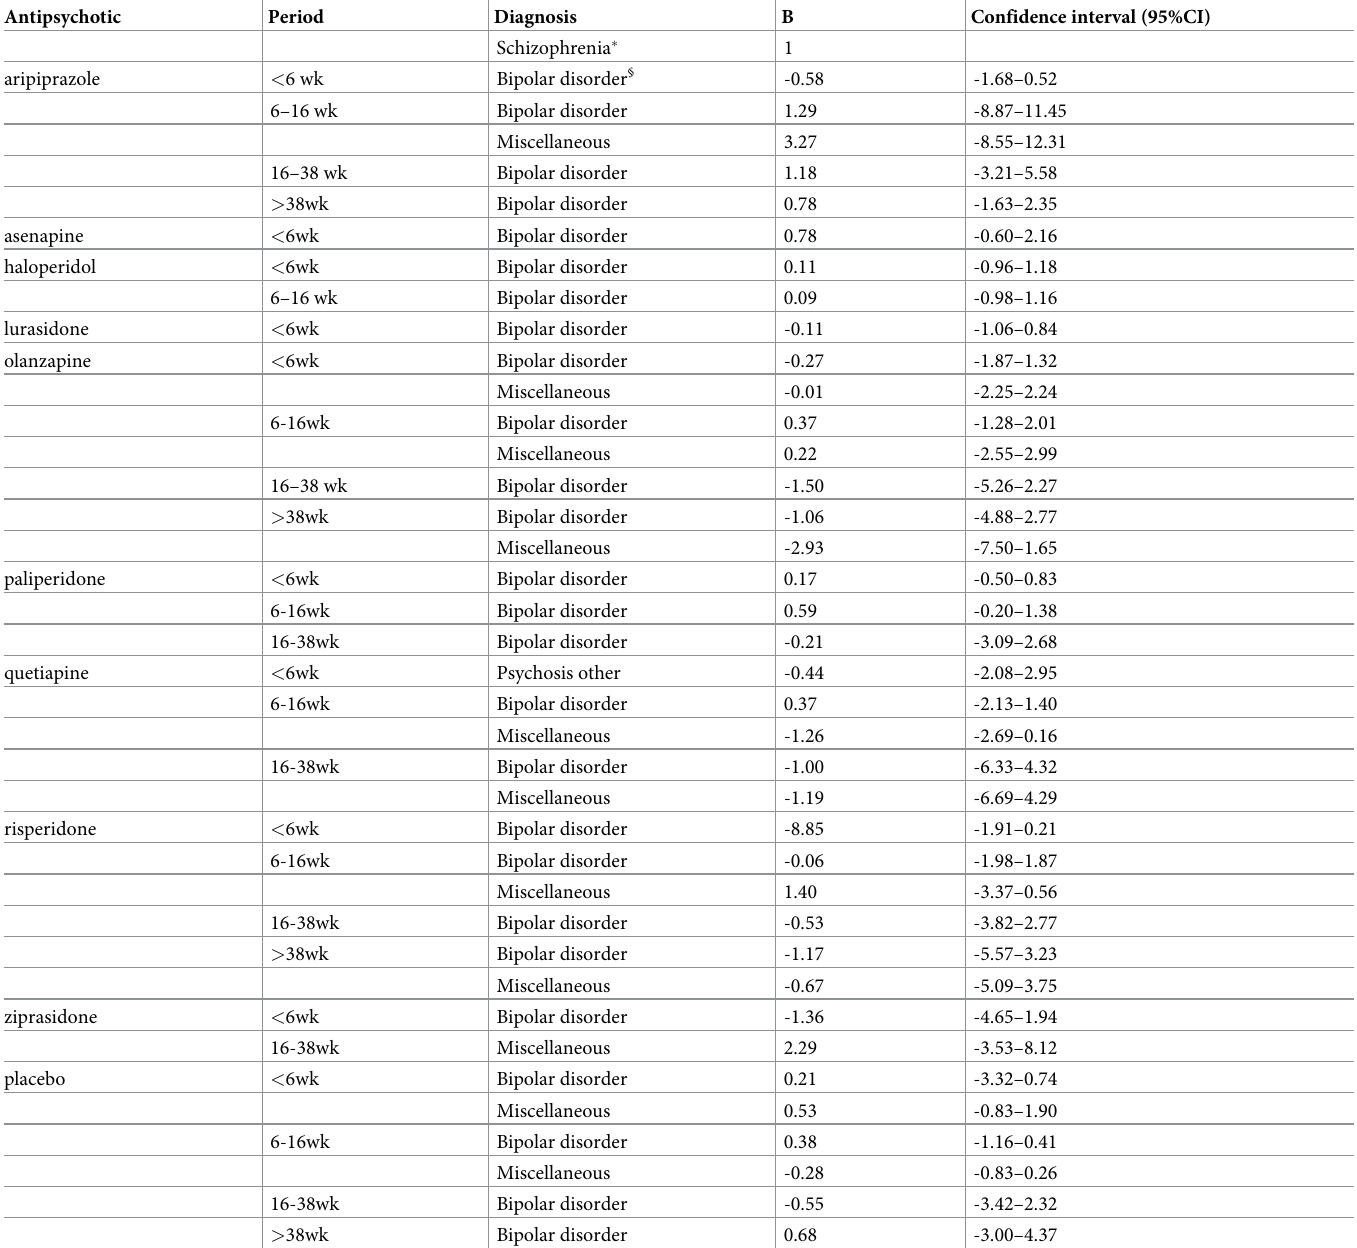
Table 4. Meta-regressions weight change per diagnosis per